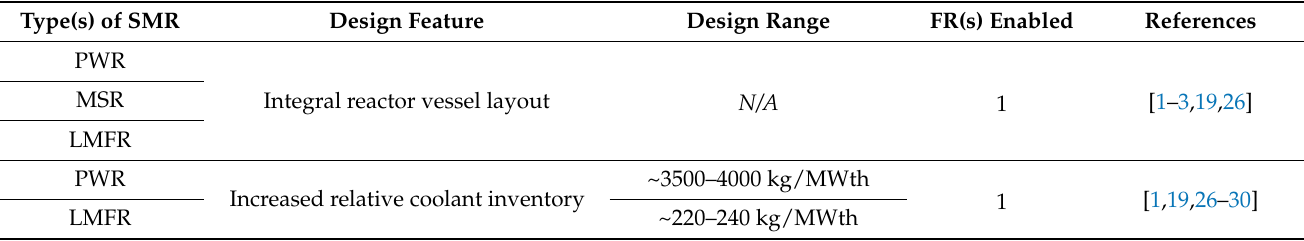
Table 2. Design features of SMRs that enable the FRs of Table